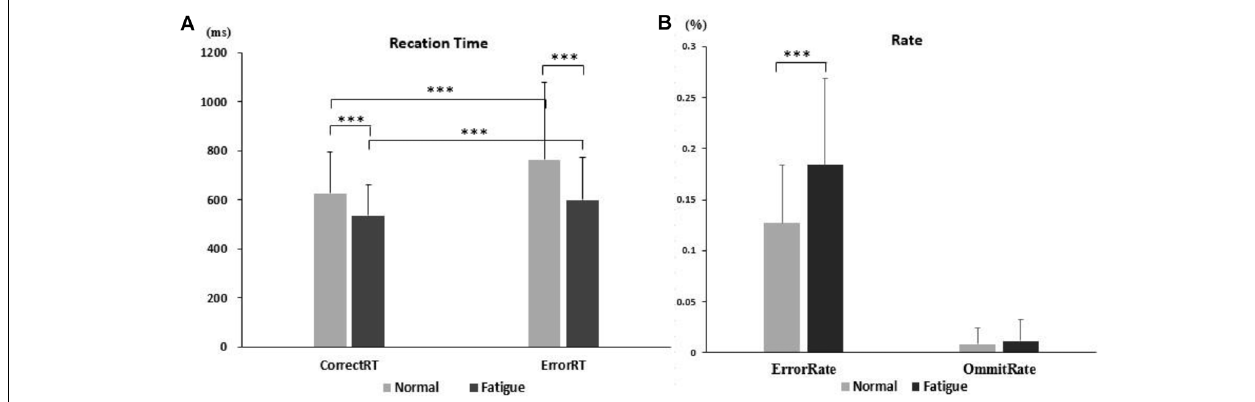
FIGURE 3 | The behavioral results. (A) The results of reaction times (RT). (B) The results of error rate and omission rate. ∗∗∗ Difference is significant at the 0.01 level.